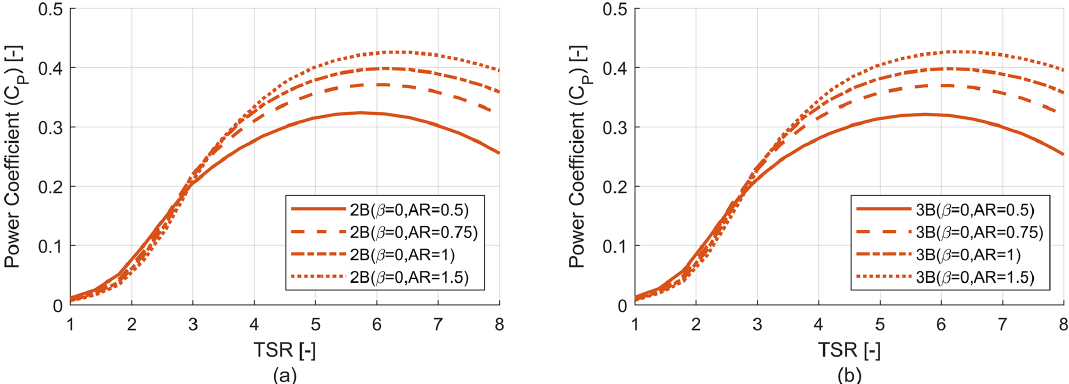
Figure 18. Power coefficient ( C P ) vs. TSR for different aspect ratio (AR) rotors.